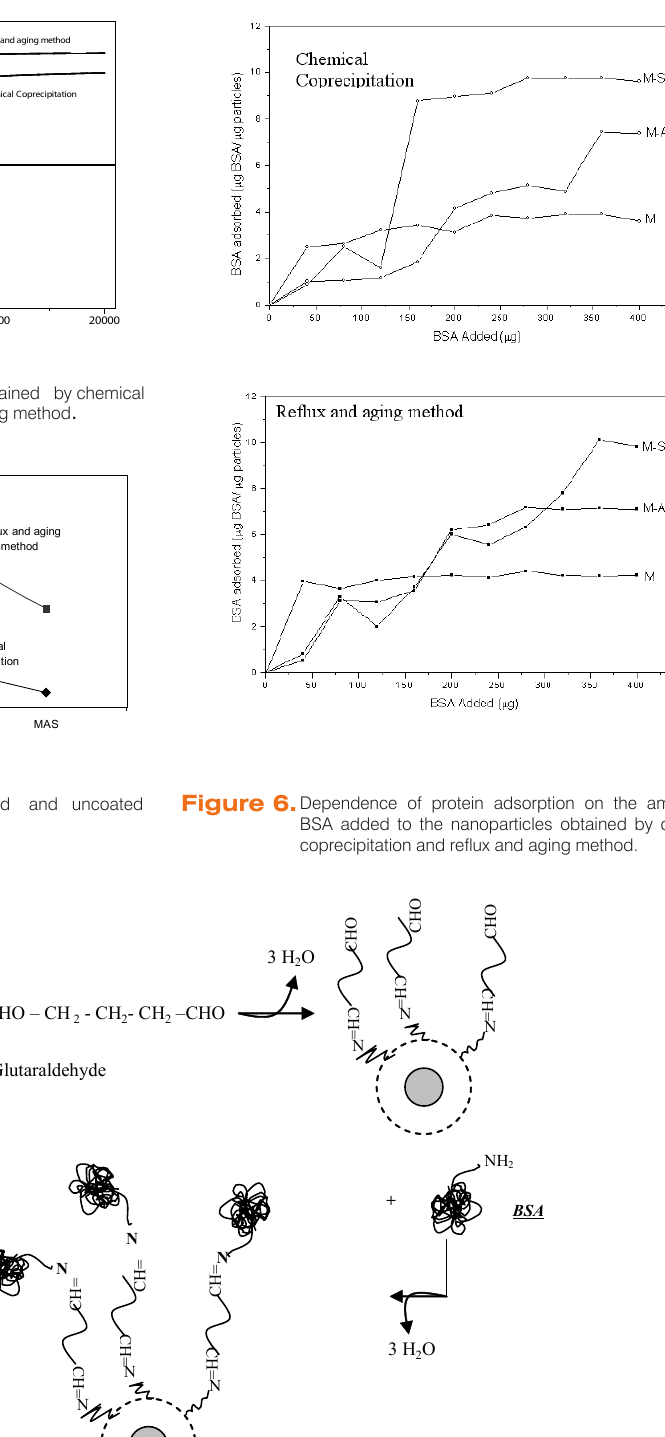
Scheme 2. Suggested mechanism of coated magnetite